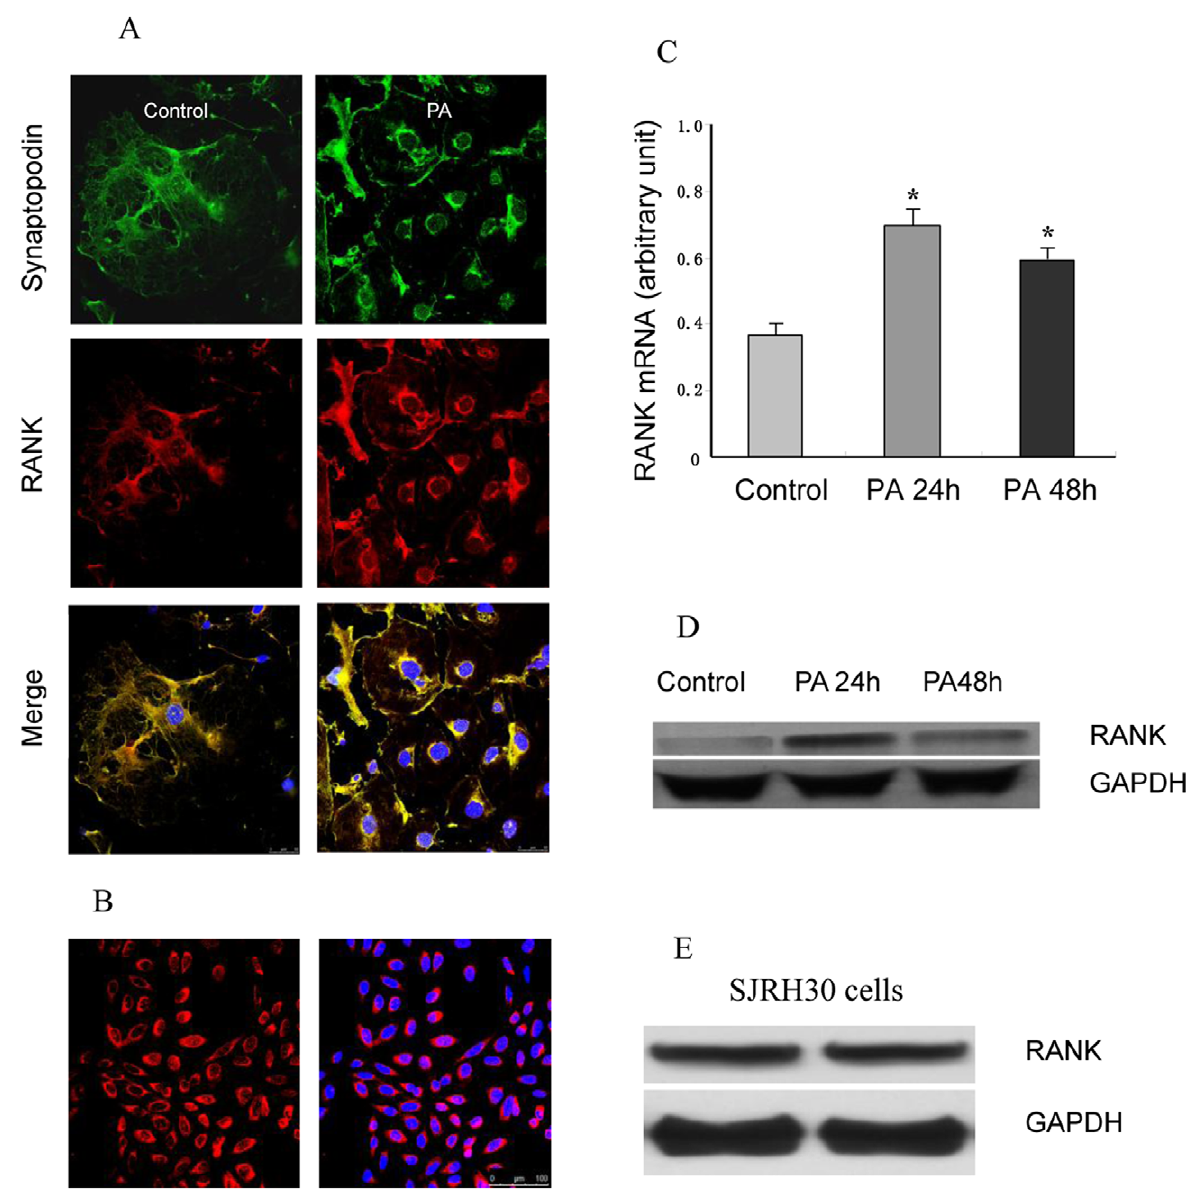
Figure 4. RANK Expression was Upregulated in a Model of Podocyte Injury in Vitro. (A) RANK expression co-localizes with synaptopodin. RANK expression was localized to the cell plasma membrane and cytoplasm. Synaptopodin (green) positive cells were positive for RANK ( red ) and showed morphology consistent with podocytes. Nuclei stained with DAPI ( blue ). (B) RANK positive controls are SJRH30 cells. RANK immunofluorescence staining of acetone-fixed SJRH30 cells showed membrane localization. Nuclei stained with DAPI ( blue ). (C) For determination of whether RANK was increased after PA (25 m g/ml) exposure, RANK mRNA was measured by real-time RT-PCR at 24 h and 48 h after PA exposure. Densitometric analyses indicate a 1.8- and 1.5-fold induction of RANK at 24 h and 48 h, respectively. Results were obtained from three independent experiments. *Compared with control, P , 0.05. (D) Whole-cell lysates were harvested 24 or 48 h after PA injury or control conditions, and RANK protein expression was determined by using Western blot analysis with RANK antibody. Glyceraldehyde-3-phosphate dehydrogenase (GAPDH) immunoblotting served as a loading control and confirmed equal protein loading between samples. RANK protein was in low abundance in the absence of PA injury. In contrast, RANK expression was increased after PA injury at 24 h and 48 h. Densitometric analyses revealed that RANK was upregulated a 3.8- and 2.4-fold at 24 h and 48 h, respectively. RANK immunoblotting revealed that RANK is activated in an autocrine manner upon PA injury in podocytes, reaching a maximum within 24 h of PA treatment. (E) SJRH30 cells are RANK positive controls. RANK protein was confirmed by Western blot in SJRH30 cells. doi:10.1371/journal.pone.0041331.g004 the induction of RANK in podocytes was not mediated through Despite the importance of podocytes in renal physiology and as the action of T or B cells. The results suggest a link between a target of glomerular disease [5], the underlying molecular RANK overexpression and podocyte injury that is independent of mechanisms that control the survival or apoptosis of podocytes lymphocyte infiltration or activation. have not been fully elucidated. The present study demonstrated